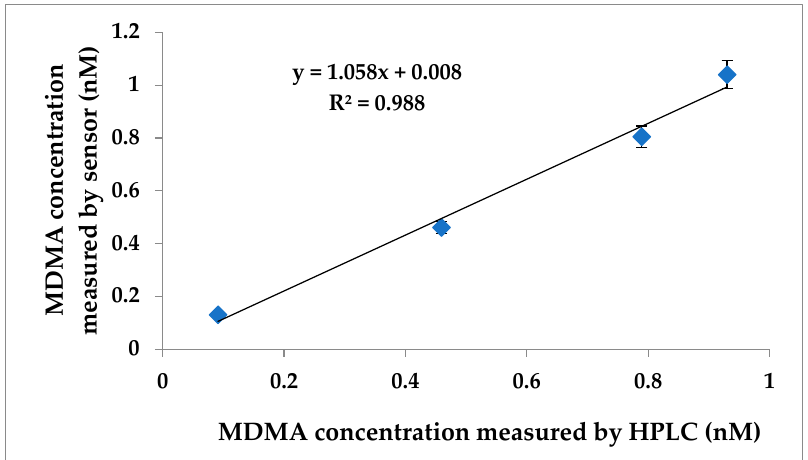
Figure 14. Correlation study of developed aptasensor compared to HPLC. Table 4. Evaluation of Apt MDMA /SnNPs@Au-based sensing system for MDMA detection in spiked urine, blood, and water samples.